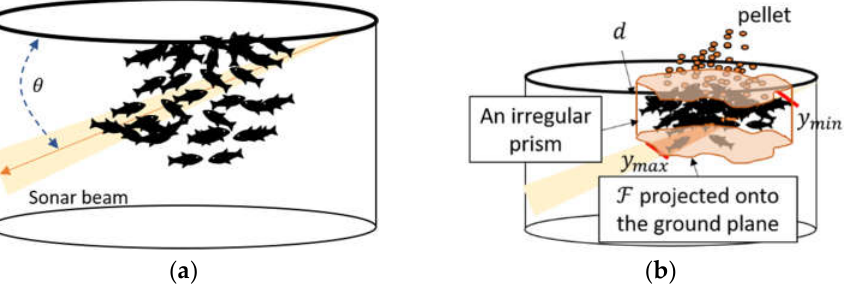
Figure 13. Illustration of the net cage and the fish school with the imaging sonar system, where ( a ) is the angle between the water and the plane of the sonar beam is θ ; and ( b ) is the feeding fish school showing is grabbing pellets during feeding which is enclosed by an irregular prism.